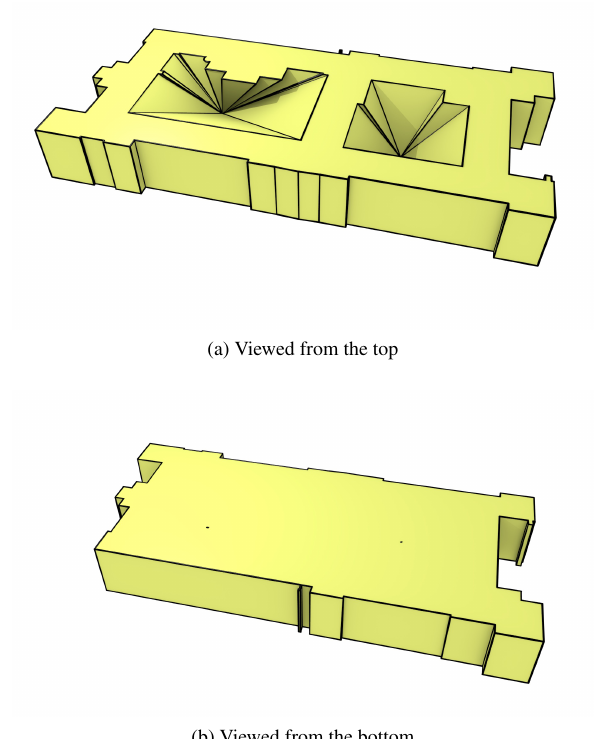
Figure 8: Collapsing the vertices surrounding both of the holes on the bottom facet of a prism. Note how in (b) the view from the bottom, the holes are collapsed into single vertices. If a sub- sequent extrusion was applied to this face, they could then be ignored and reflect a smoothly changing